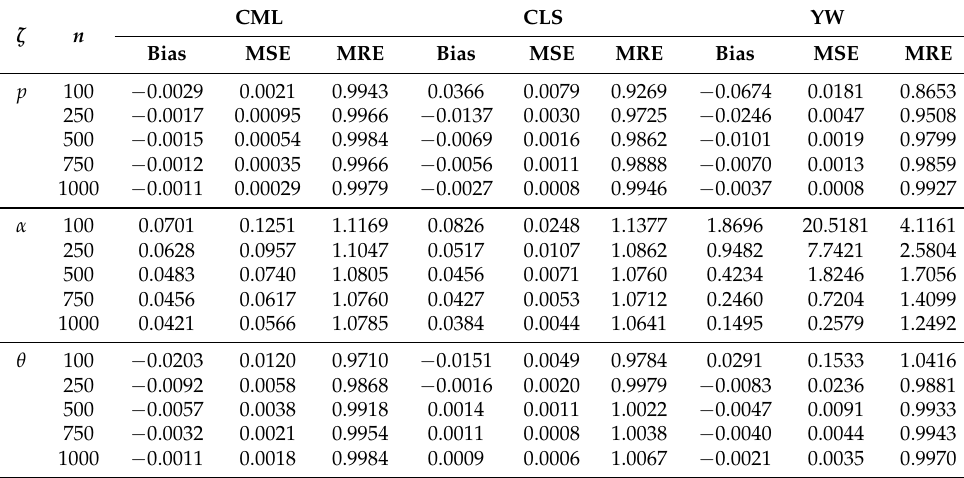
Table 3. Simulation results for ( p = 0.5, α = 0.6, θ = 0.7).